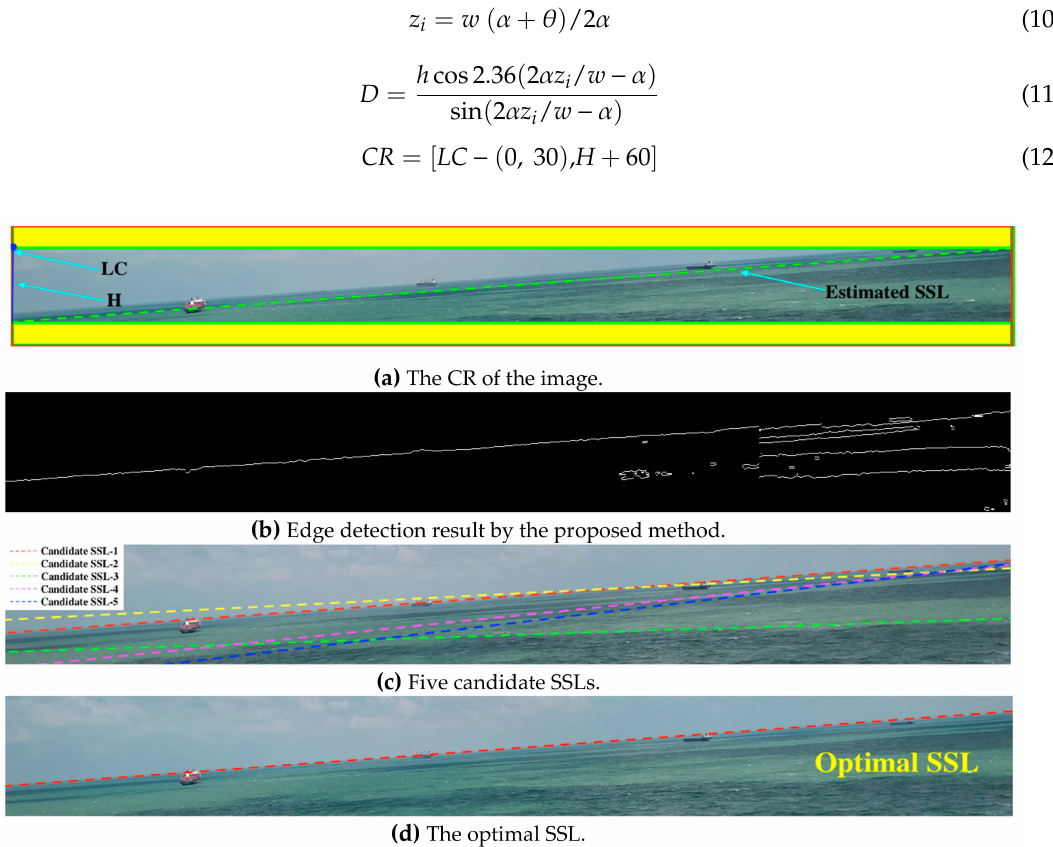
Figure 7. Figures of each stage in the SSL extraction algorithm. In ( a ), the camera parameters are h = 20 m, α = 3.7 ◦ , l = 1288 pixels, w = 964 pixels; the inertial sensor parameters are β = 0 and the green dotted line represents the estimated SSL obtained by the camera motion attitude